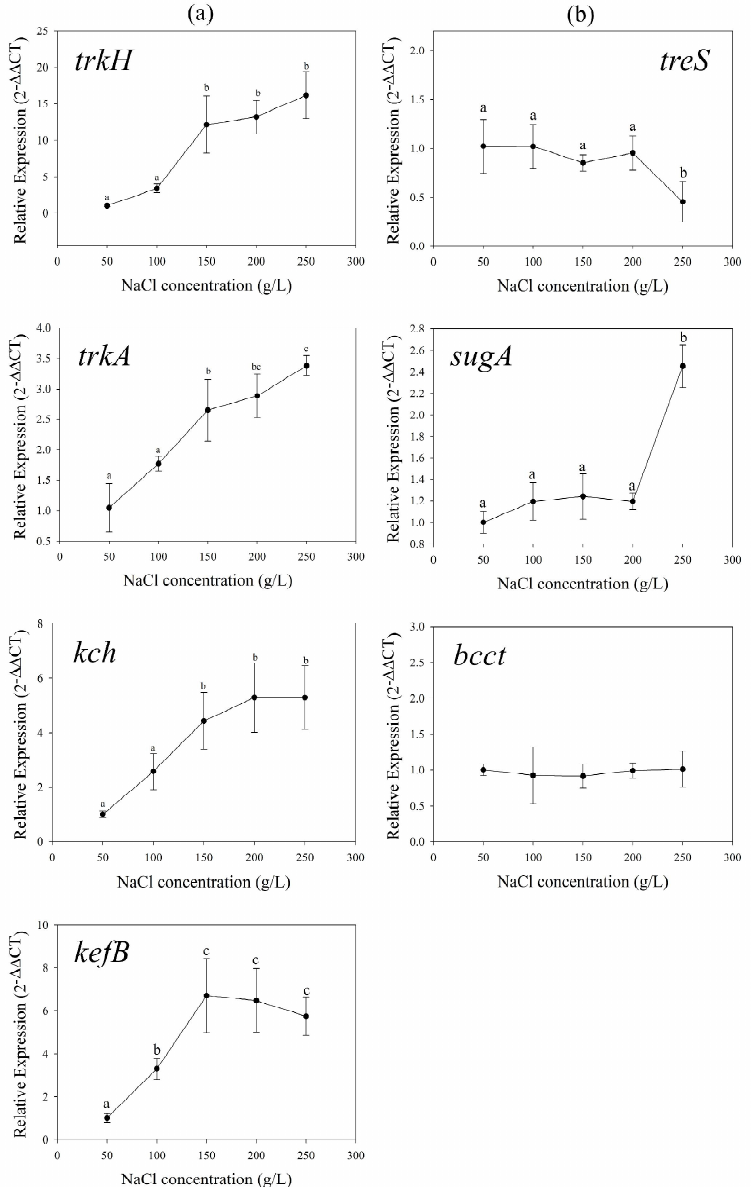
Figure 6. The relative expression levels of potassium uptake genes trkH , trkA , kch and output gene kefB ( a ), amylase/trehalose synthesis gene treS , compatible solutes transport genes sugA and BCCT family gene ( b ) in different salt concentration with adding exogenous trehalose.